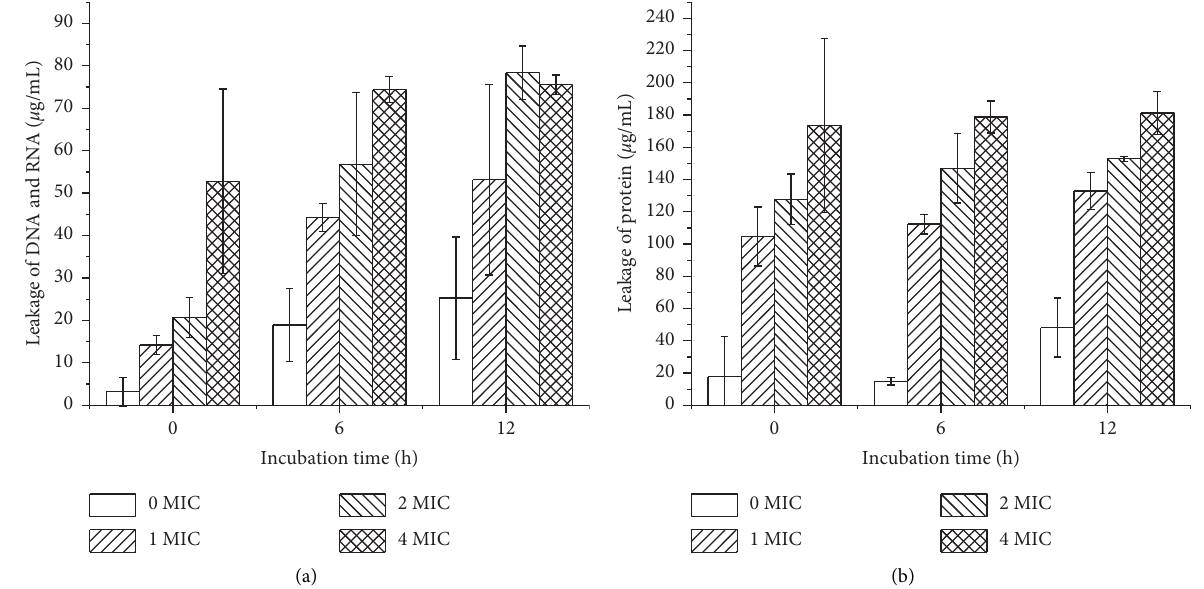
Figure 3: Leakage of DNA\RNA (a) and protein (b) from P. antarctica treated with